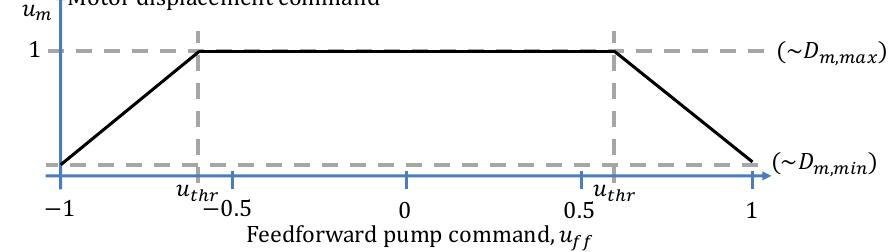
Figure 3. Motor displacement control due to u f f